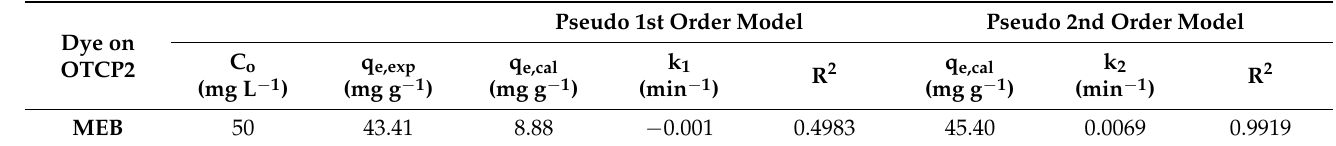
Figure 8. Pseudo first-order ( a ) and pseudo second-order ( b ) models of MEB on OTCP2. Table 4. Pseudo first-order and pseudo second-order kinetic model parameters for the adsorption MEB on OTCP2.